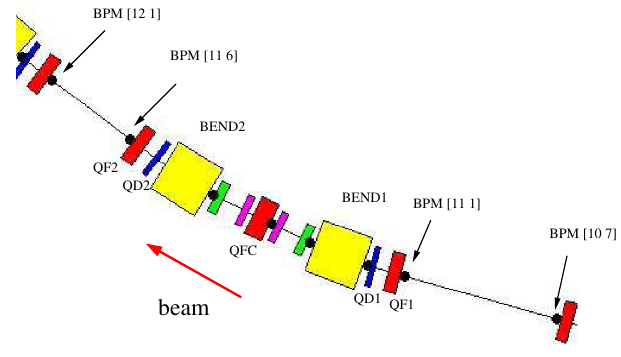
FIG. 2. The SPEAR3 cell for the